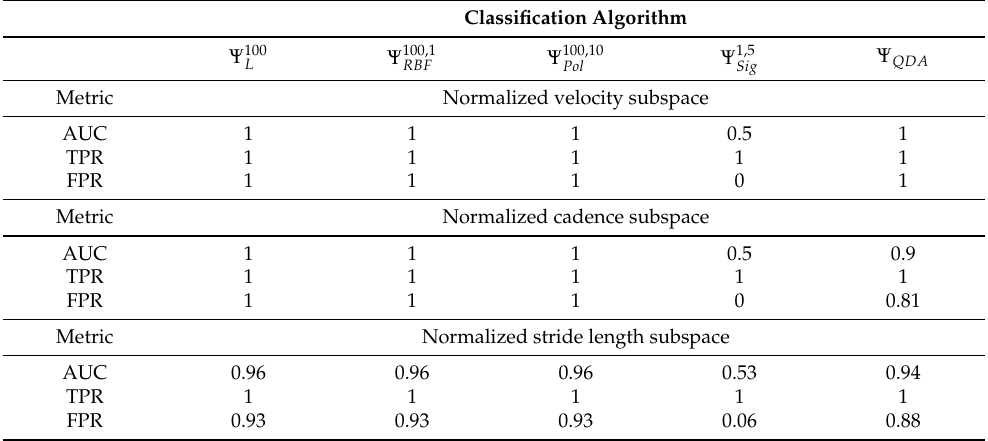
Table 7. Result of classification—improvement vs.